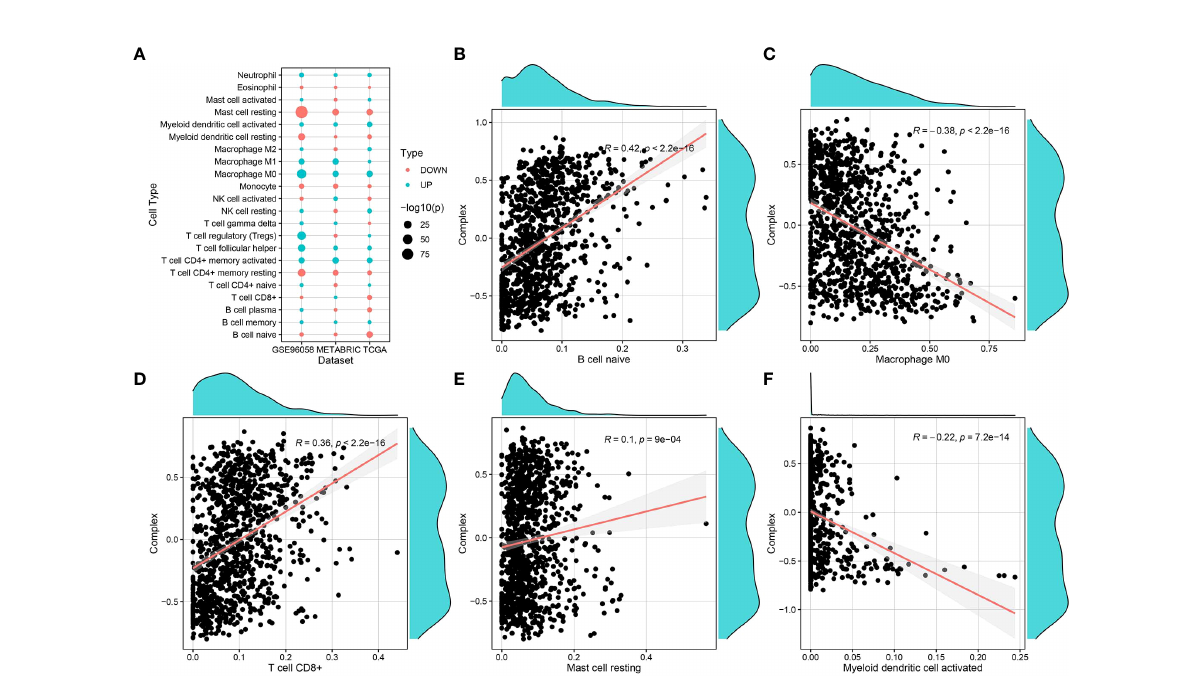
FIGURE 5 Correlation of complex prognostic values and immune in fi ltrating cells. (A) Differences in the distribution and proportion of immune cells in the TCGA-BRCA, GSE96058, and METABRIC datasets. (B – F) Correlation analysis of complex values with the proportion of different immune cell